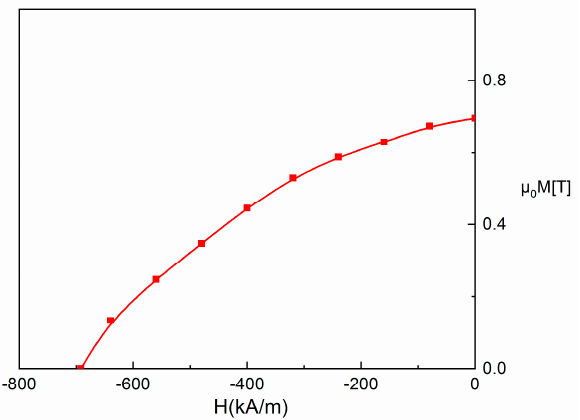
Figure 9. Demagnetization curve plotted from the hysteresis loop for the annealed sample.